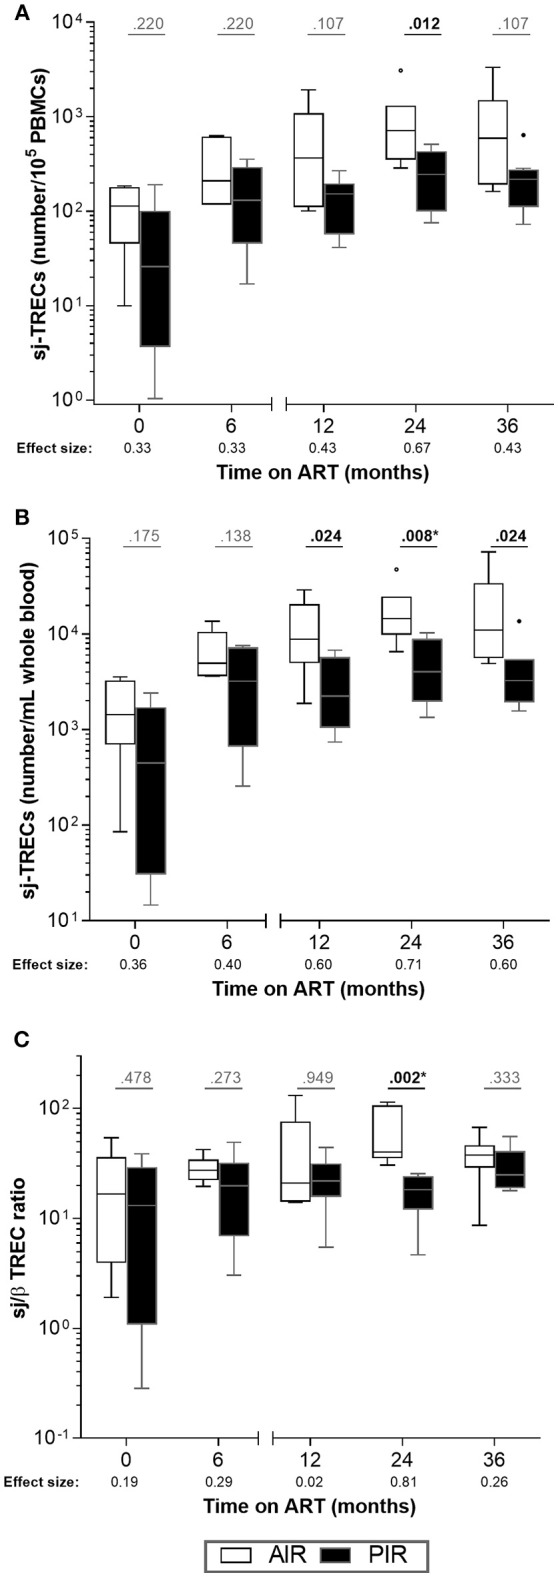
No major differences were observed in intrathymic proliferation between AIR and PIR. (A) sj-TRECs/105 PBMCs, (B) sj-TRECs/mL of whole blood and (C) sj/β TREC ratios were compared throughout ART between AIR and PIR. A Wilcoxon-Mann-Whitney U-test was performed to compare the two groups of patients at each time point, and the corresponding r is presented as a measure of effect size. *Significant after Bonferroni correction (α/5 = 0.010).